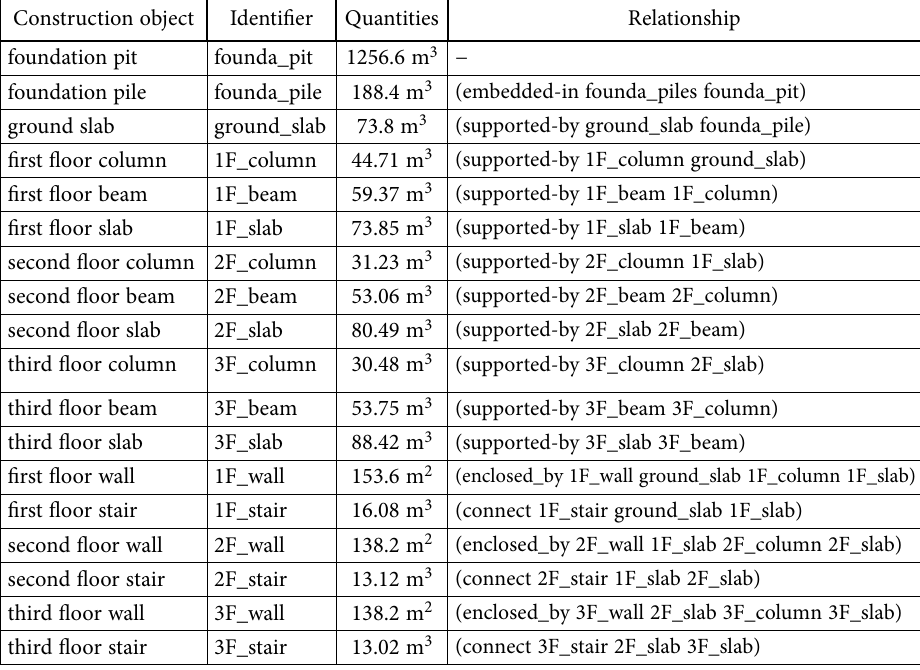
Table 3. Information of primitive construction objects